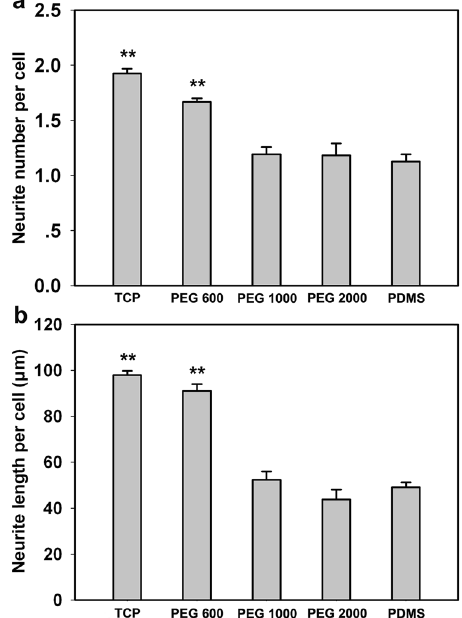
Fig. 7 Statistical images of a neurite number for each PC12 cell and b neurite length for each PC12 cell on PDMS and PDMS-PEG-PLL with PEG at various molecular weights in the presence of NGF on day 7. PC12 cells cultured on TCPs act as the positive control. Data are presented by mean ± SEM ( n = 12). Symbol ** represents the statistic difference ( p < 0.01) in comparison to